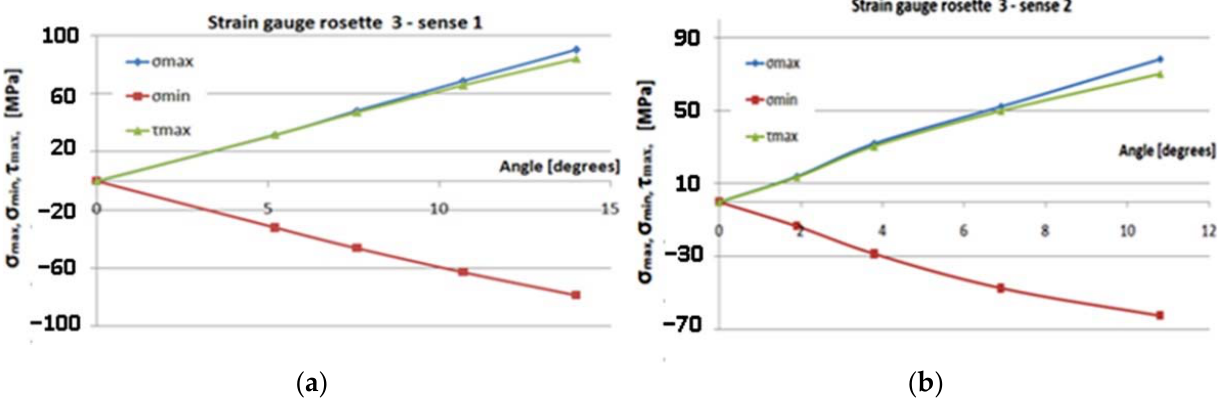
Figure 19. Gauge 3–sense 1,2: the variation of the maximum normal main stress σ max , σ min , and τ max , in relation to the angle of rotation. ( a ) Sense 1; ( b ) sense 2.